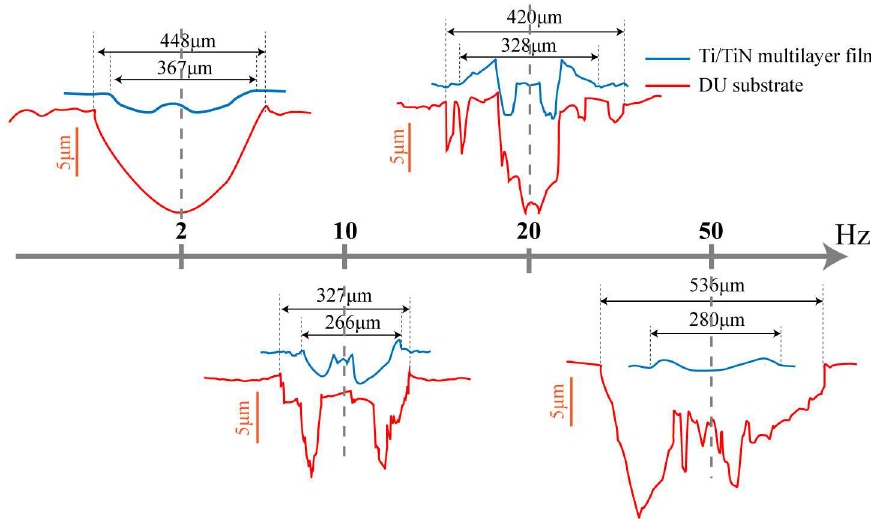
Fig 8. The 2D profiles of DU and Ti/TiN multilayer film under different test